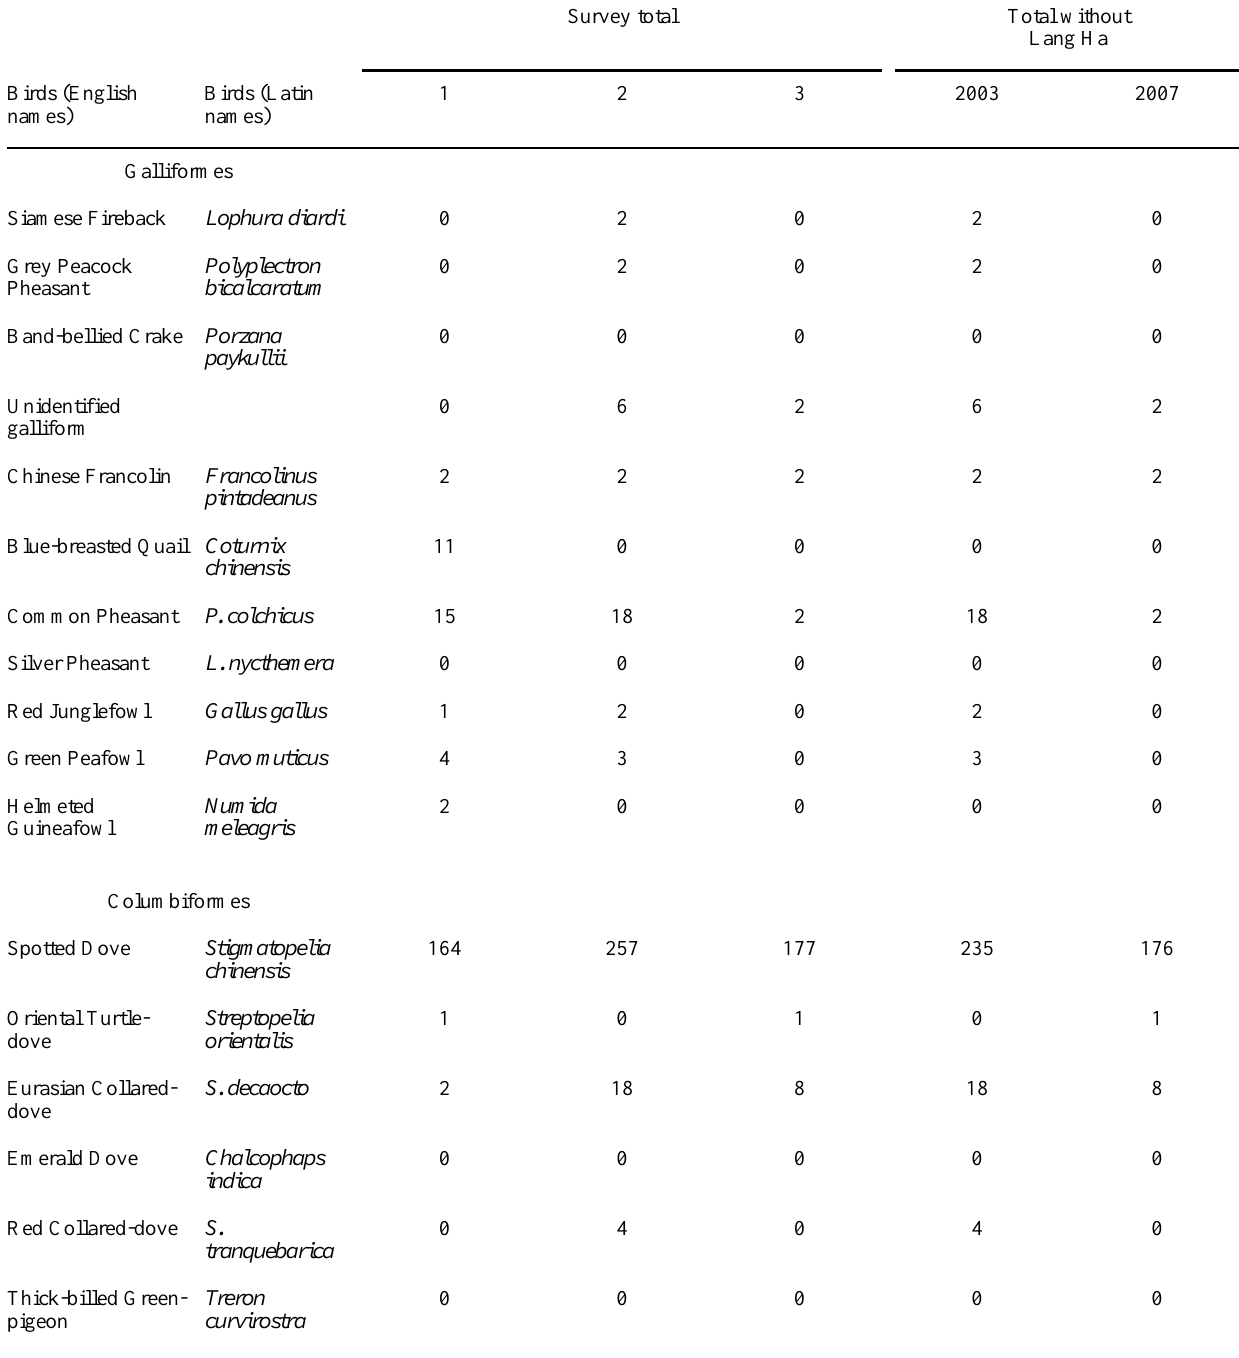
Table 2 . Comparative table of bird species recorded in Hanoi markets in surveys in 2000, 2003 and 2007. Survey 1 took place on 30 July 2000, Survey 2 ran from 26 July 2003 to 9 August 2003, and Survey 3 extended from 3 May 2007 to 22 May 2007. Survey total Total without Lang